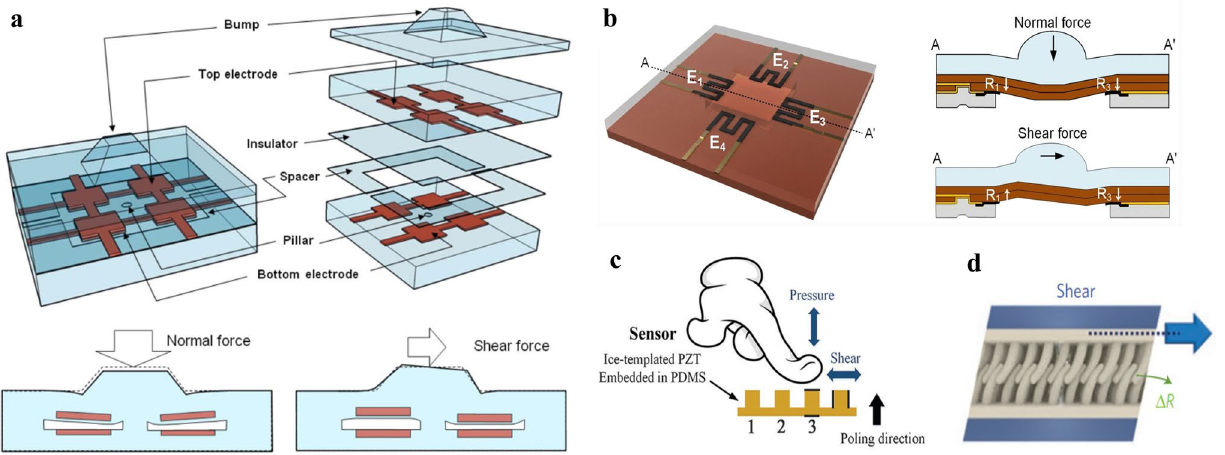
Fig. 7 Typical design strategies of flexible shear sensors. a A bump with four distributed underlying capacitive sensing elements [148]. Copy- right (2008) IEEE. b A bump with four distributed underlying resistive sensing elements [152]. Copyright (2019) The Authors. c A surface pil- lar vertically sandwiched by two electrodes [146]. Copyright (2018) The Authors. d Interlocking arrays of nanofibers [153]. Copyright (2012) Springer